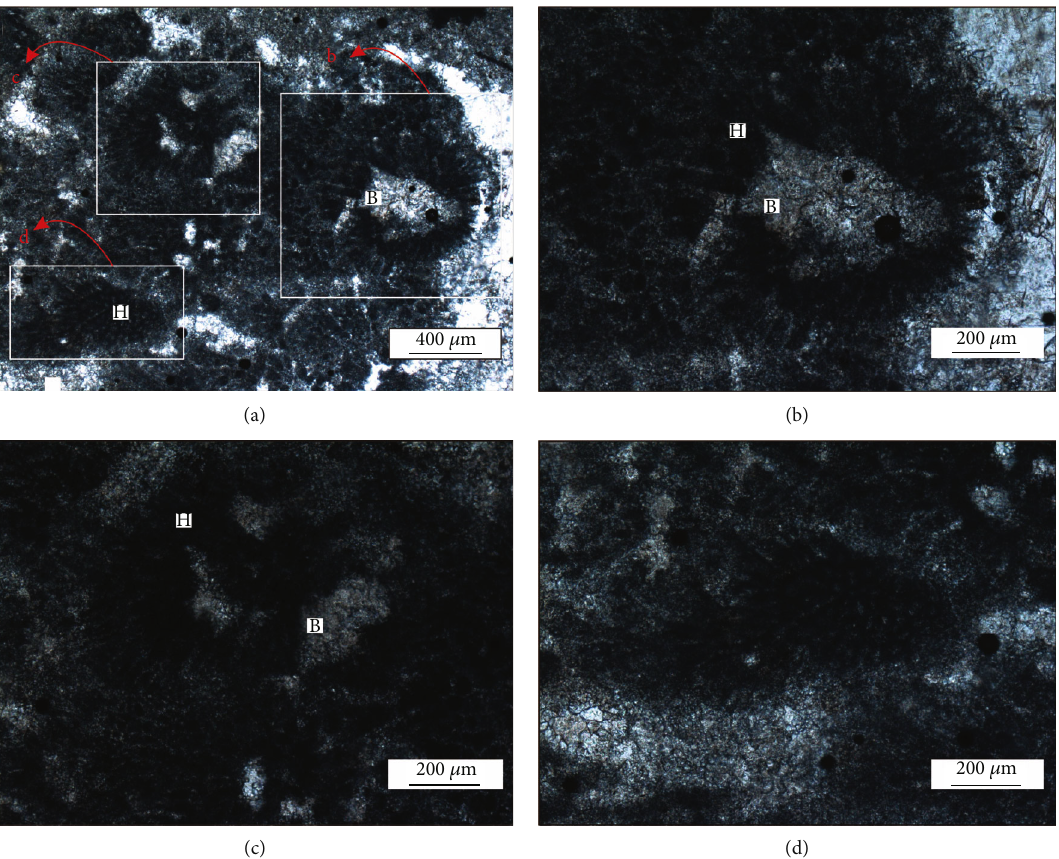
Figure 9: Micrographs of Hedstroemia in dendrolites of Zhangxia Formation in Houziyu Section, Shandong Province. (a) Symbiosis between a typical Hedstroemia (H) community and a possible Bacinella- like fabric (B); (b – d) enlarged image of the boxed area in (a); (b) atrioventricular Hedstroemia (H) with short branches spreading to all sides; (c) cluster globular Hedstroemia (H) symbiosis with possible Bacinella -like fabric (B), branching outwards in a fan pattern; and (d) small shrubby Hedstroemia (H) grew outwards on the base of nitrogen- fi xing cells and tapered at the tip of the